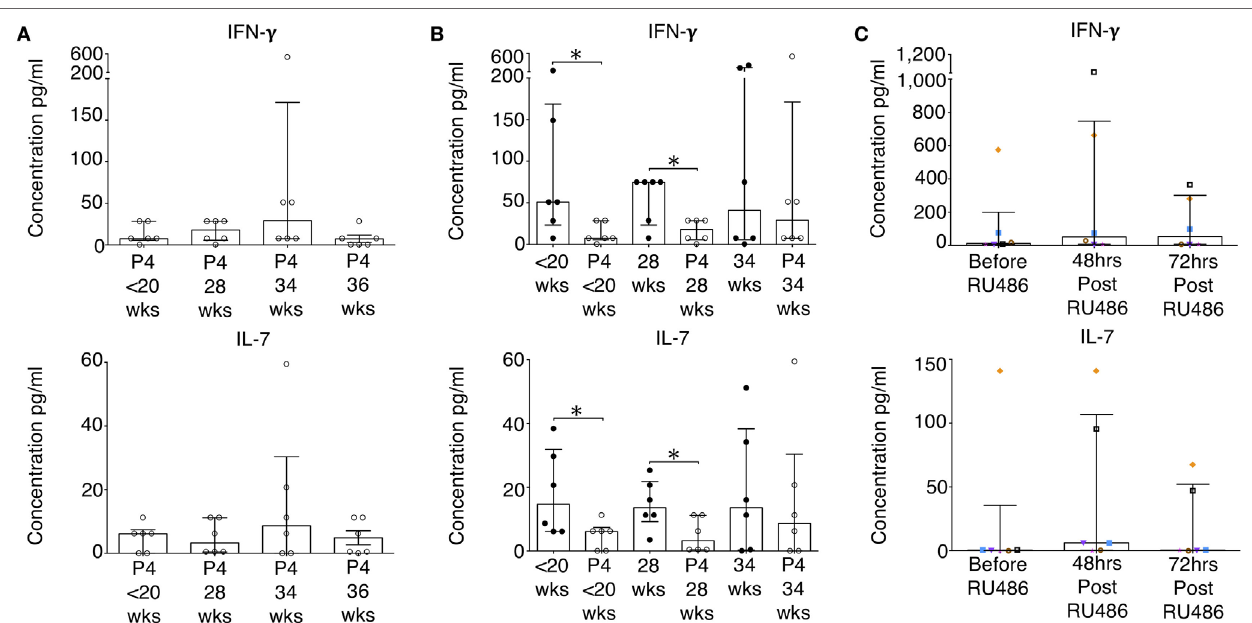
FigUre 7 | Baseline concentrations of pro-inflammatory cytokines in the P4-treated group are reduced. Plasma concentrations of cytokines measured by 17-plex multiplex assay were determined. (a) Longitudinal analysis of IFN- γ and IL-7 concentrations of noted in the P4 treated group. (B) IFN- γ and IL-7 concentrations in P4 treated compared to gestation-matched controls. Unpaired Mann–Whitney U test. (c) Longitudinal analysis of RU486 effect on plasma cytokine concentrations. A representative sample of patients ( N = 6 ) were assessed. Gestation at sampling is indicated: in pregnant controls ( ⚫ ) at < 20 + 0 weeks ( N = 42 ), 28 weeks ( N = 35 ), 34 weeks ( N = 33 ); and P4 treated pregnancies ( ⚪ ) at < 20 + 0 weeks ( N = 15 ), 28 weeks ( N = 11 ), 34 weeks ( N = 11 ), 36 weeks ( N = 10 ). For RU486 treated ( N = 6 ) symbols represent individual patients. Longitudinal data were analyzed with Freidman test with Dunn’s post hoc correction. P values are two tailed and significance is defined as * P <